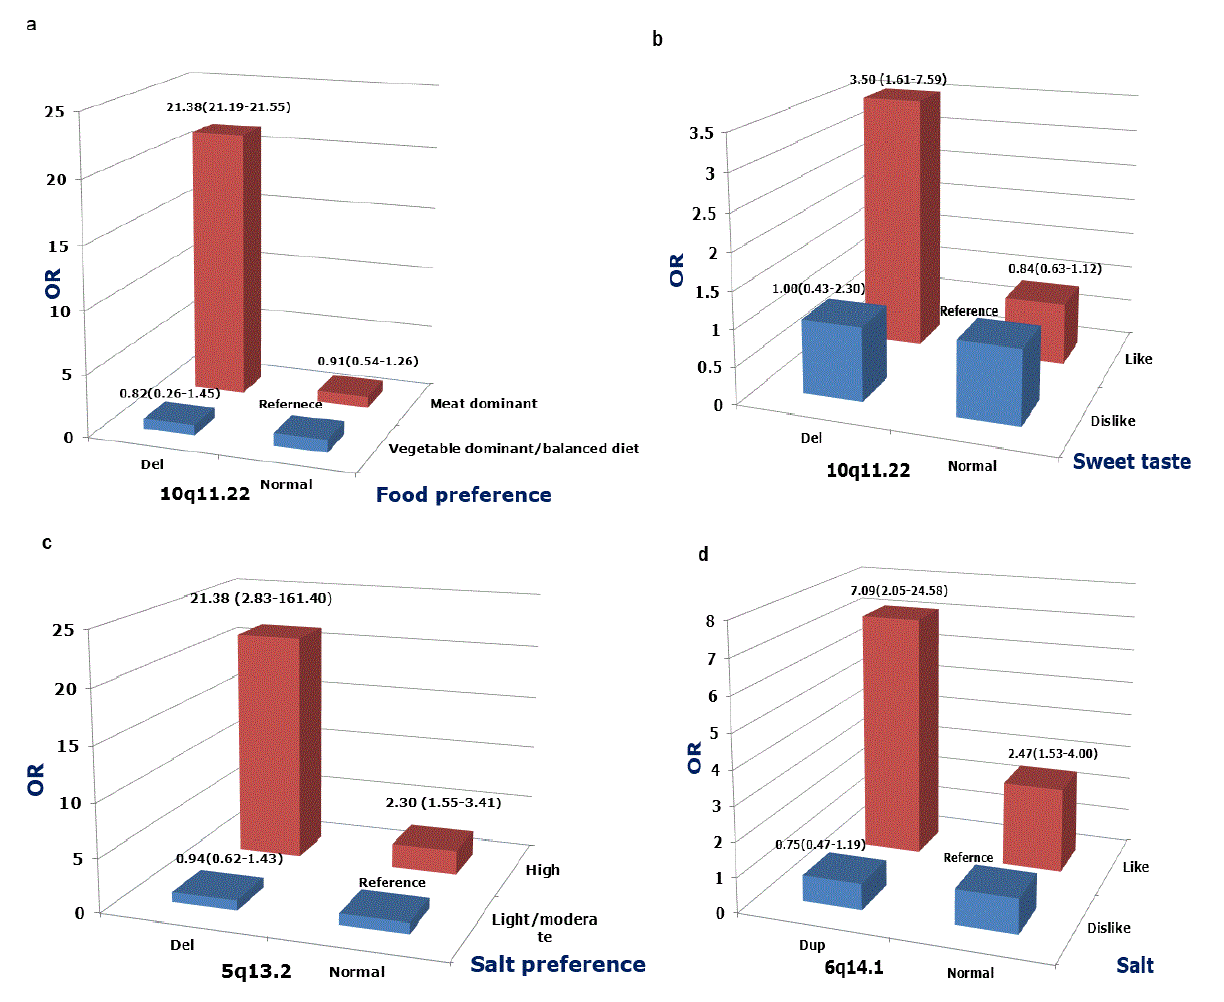
Figure 2. Positive CNV-diet interactions on the risk of obesity. Odds ratio (OR) (95% CI) for the risk of developing obesity were calculated by logistic regression adjusted for age and